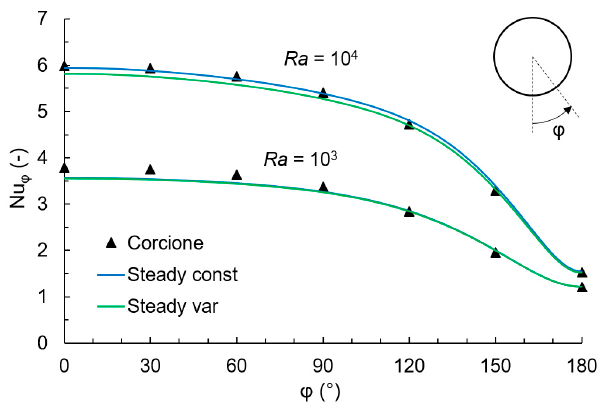
Figure 3. The comparison of the local Nusselt numbers Nu φ of the single cylinder for various computational models at Ra = 10 3 and Ra = 10 4 .